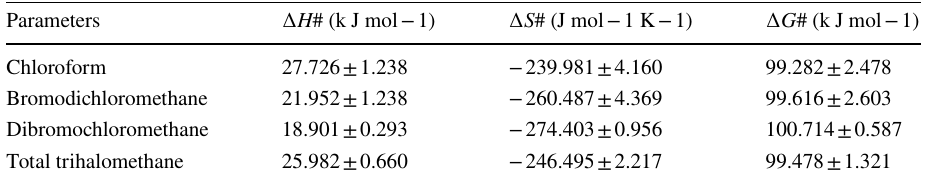
Table 3 Thermodynamic parameters (Δ H # , Δ G # (k J mol −1 ) and Δ S # (J mol −1 K −1 )) for the formation of trihalomethanes at 25 °C